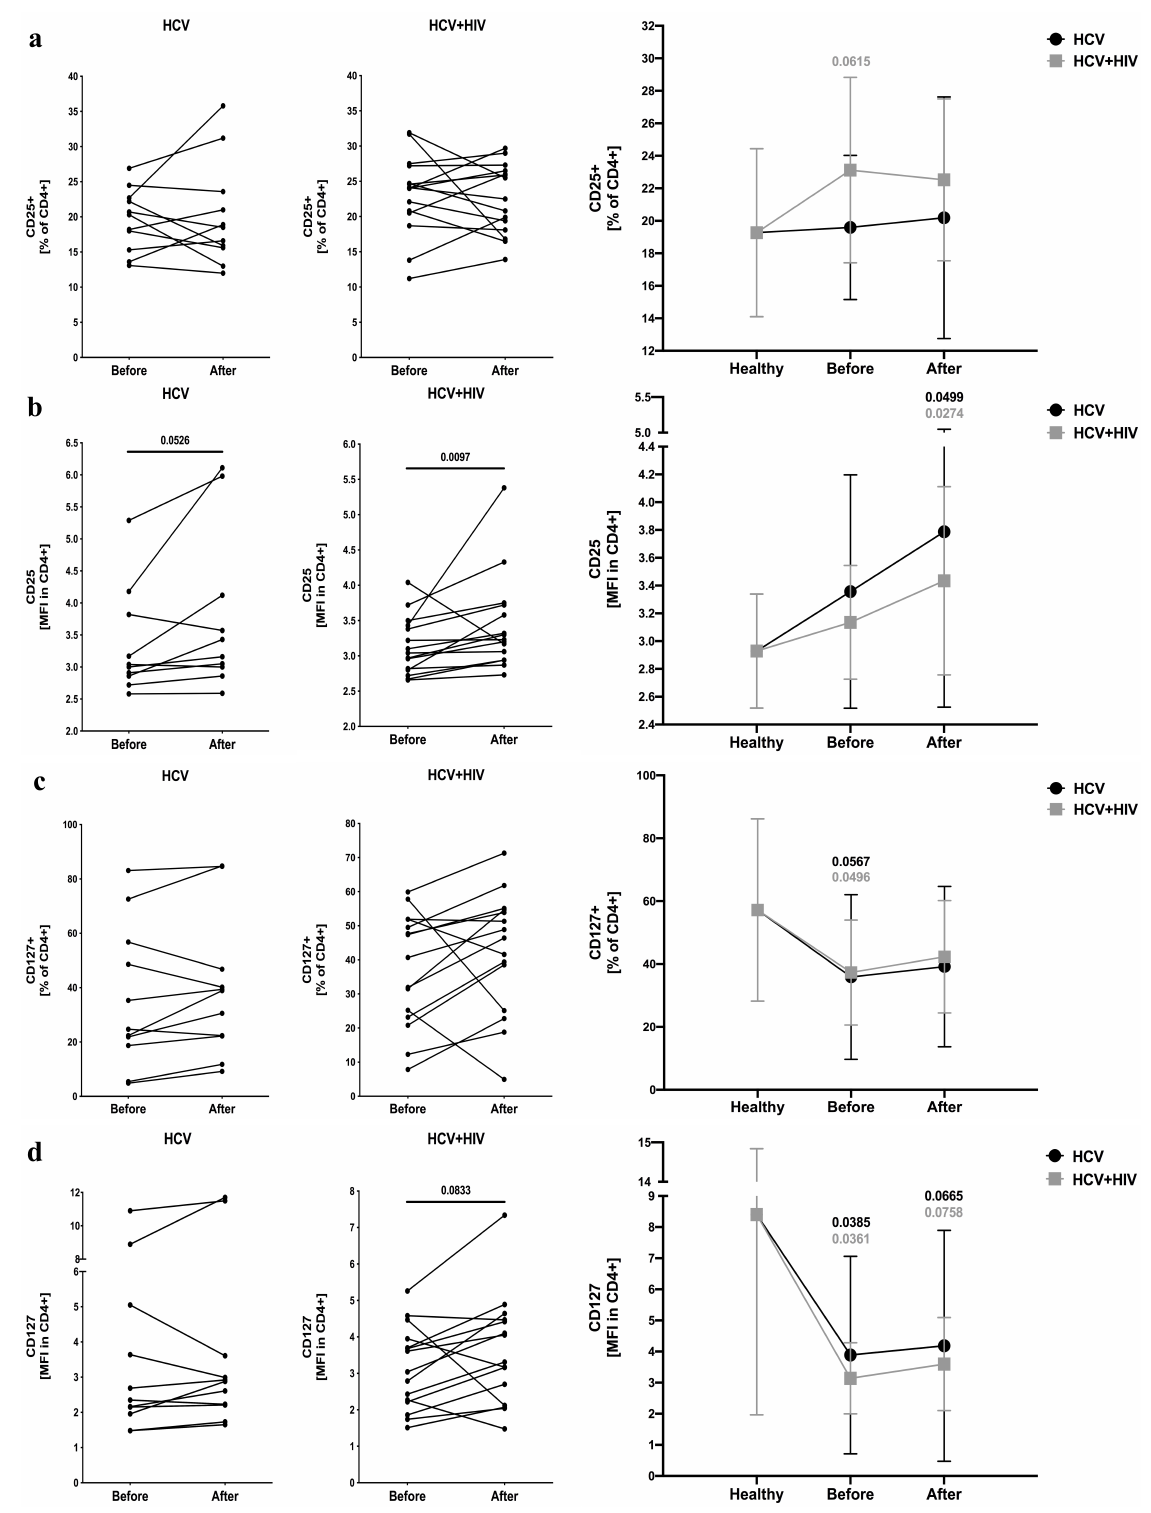
Figure 3. Alterations in T cells activation- (CD25) and development-related (CD127) proteins in the course of anti-viral treatment of HCV-infected and HCV/HIV-coinfected patients. Data presenting effects of therapy and differences between studied groups in the course of treatment in relation to healthy control subjects. CD25 activation marker was analyzed as frequency ( a ) and mean fluorescence intensity (MFI) ( b ) within CD4 + lymphocytes, and similarly, CD127 was demonstrated as frequency of marker-positive cells ( c ) and MFI ( d ) in CD4 + T cell